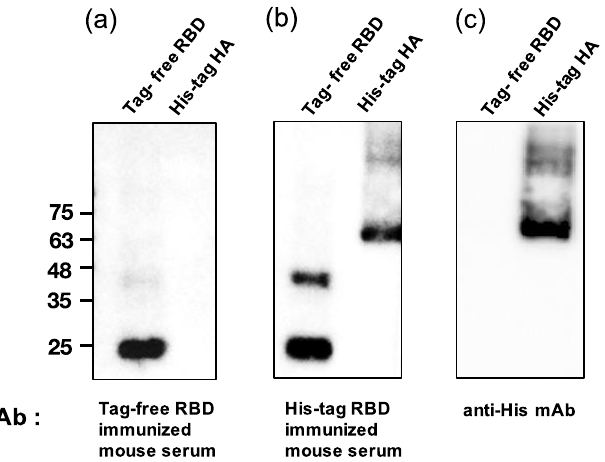
Figure 5. Analysis of mouse sera binding with irrelevant His-tag influenza viral protein. Tag-free RBD and His-tag HA were used as loading antigens and probed with tag-free-RBD-immunized mouse serum (1:800) ( a ), His-tag immunized mouse serum (1:800) ( b ), and the anti-His mAb (1:1000) ( c ).